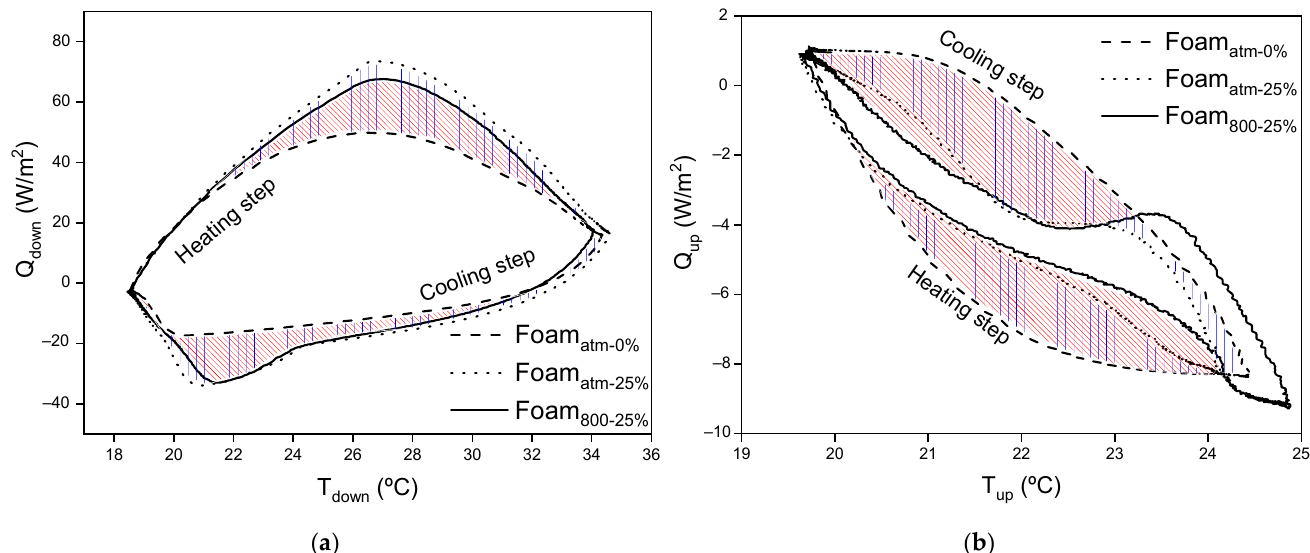
Figure 12. Variation of the input and output heat fluxes for a heating-cooling cycle as function of the outdoor or indoor temperature, ( a ) Q down vs T down and ( b ) Q up vs T up .